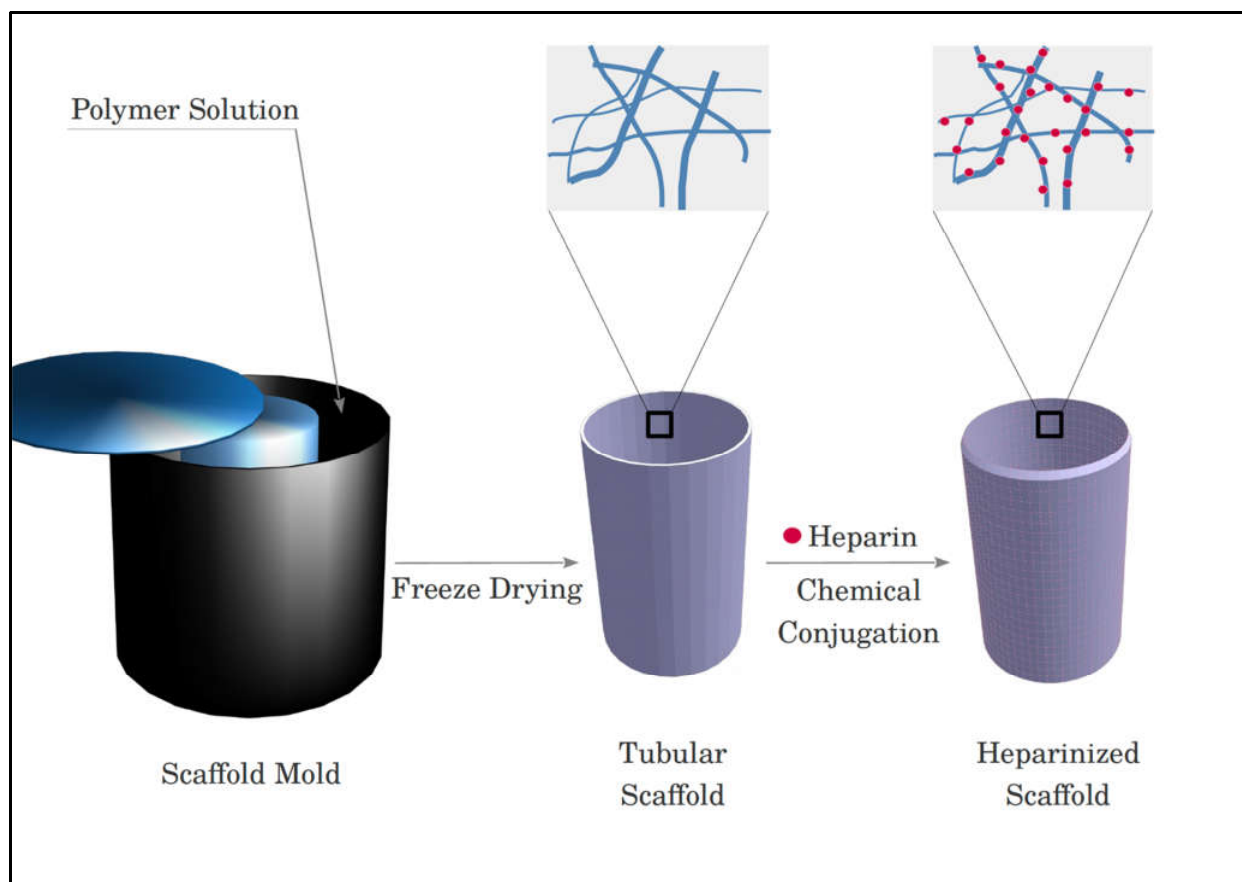
Figure 4. A scheme of chemical conjugation. Mixture of solution was poured to heated molding chamber and freeze-dried at −80 °C. Lastly, heparin added to the scaffold for covalent bonding.